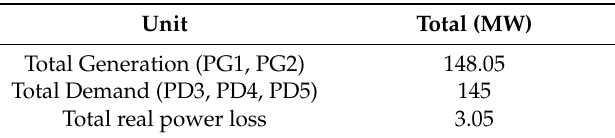
Table 1. Generation, load demand, and losses for the five-bus IEEE